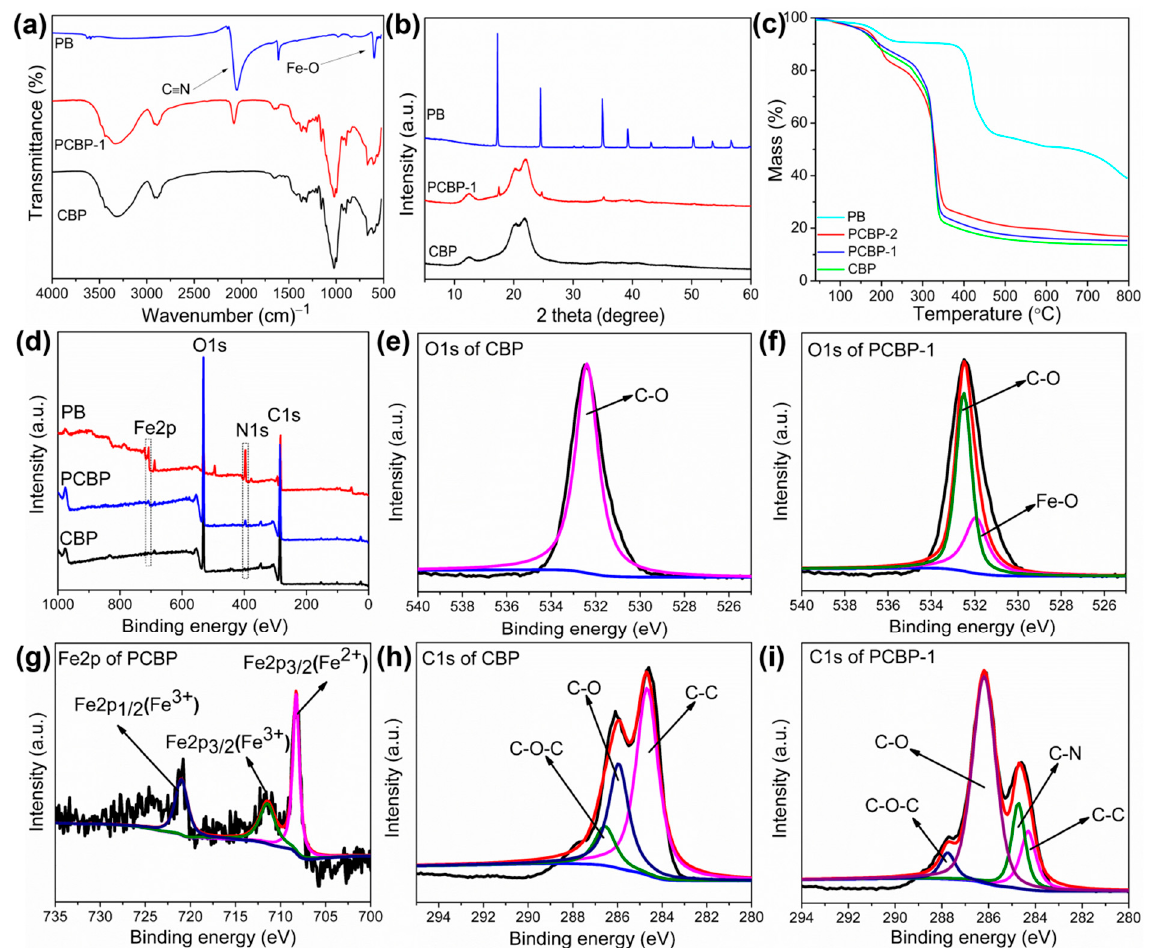
Figure 4. ( a ) FITR spectra of PB, CBP, and PCBP-1; ( b ) XRD patterns of PB, CBP, and PCBP-1; ( c ) TGA curves of PB, CBP, PCBP-1 and PCBP-2; ( d ) XPS survey of PB, CBP and PCBP-1, and ( e , f ) high-resolution XPS spectra of CBP and PCBP-1 at O 1s region; ( g ) Fe 2p spectra of PCBP-1; ( h , i ) C 1s spectra of CPB and PCBP-1.